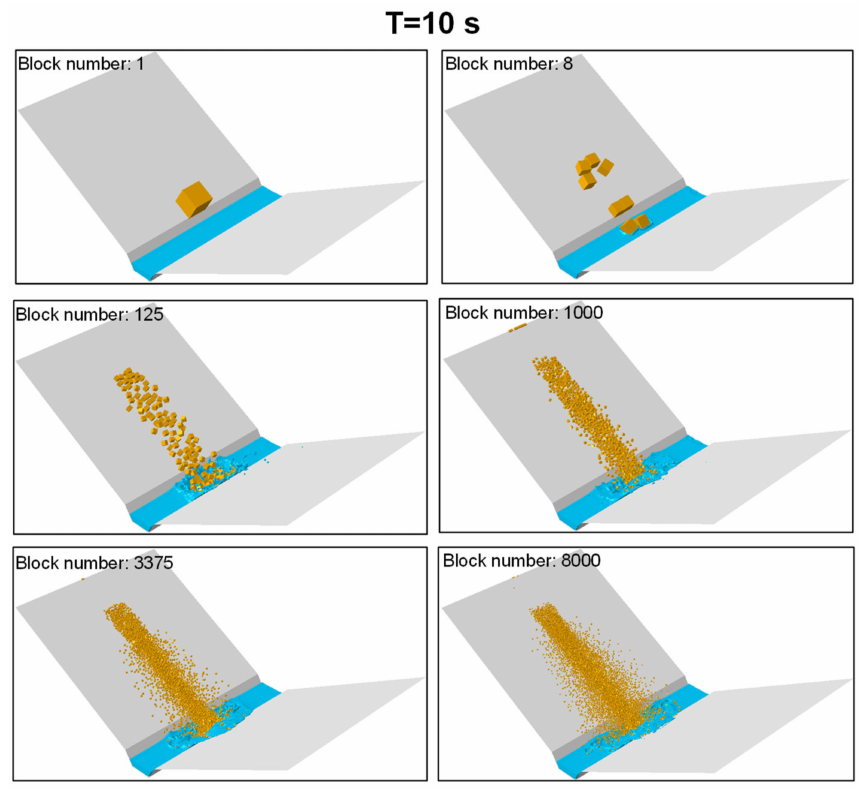
Figure 9. Scenes of the runout behavior for different fracturing degrees of the source